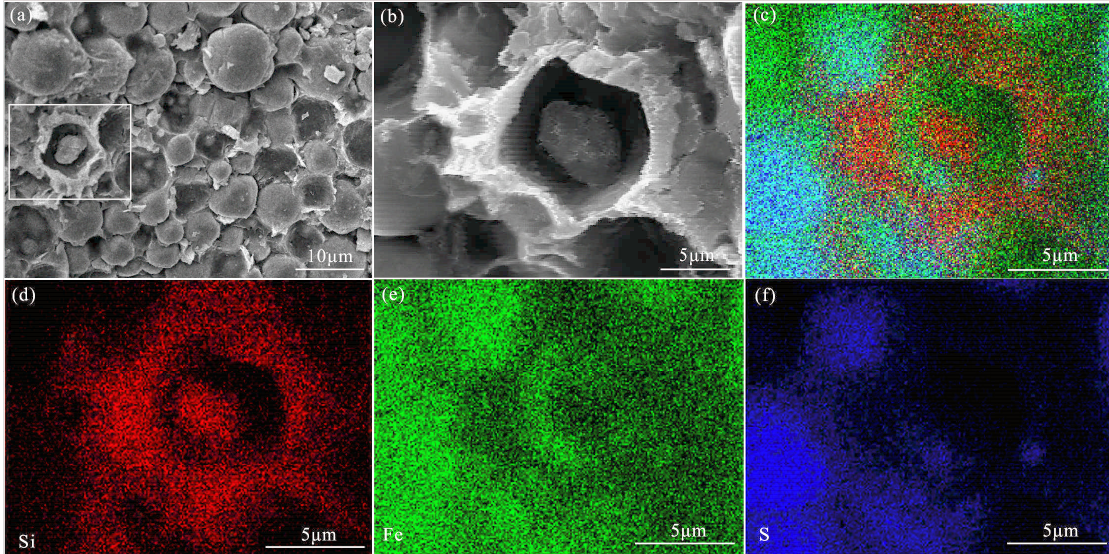
Figure 5. Elemental mapping test results of microfossil Microcystis . ( a , b ) SEM photographs of a cracked spheroid; ( b ) is the magnified view of the rectangle in ( a ); ( c – f ) Elemental mapping test of the cracked spheroid, mainly composed of Si, Fe, and S.